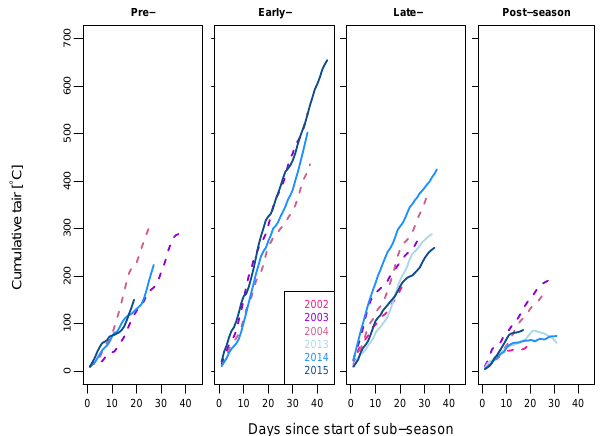
Figure B1. Sub-seasonal air temperature (at a 6m height) budgets for the control area for the historic (2002–2004) and recent (2013– 2015) datasets. Time axes within this plotting scheme are identical to those used in Fig. 5.